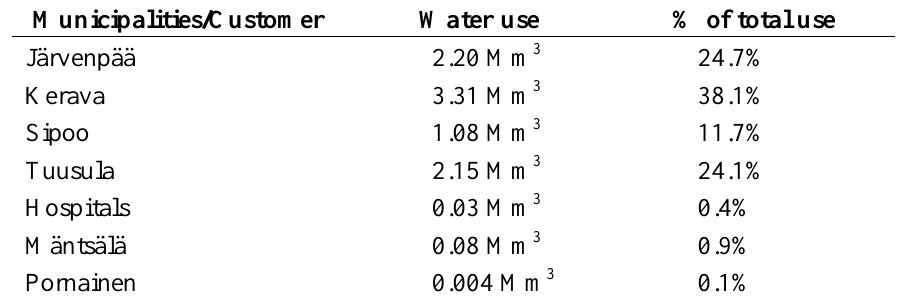
Table 2. Water consumption in Tuusula region municipal water authority in